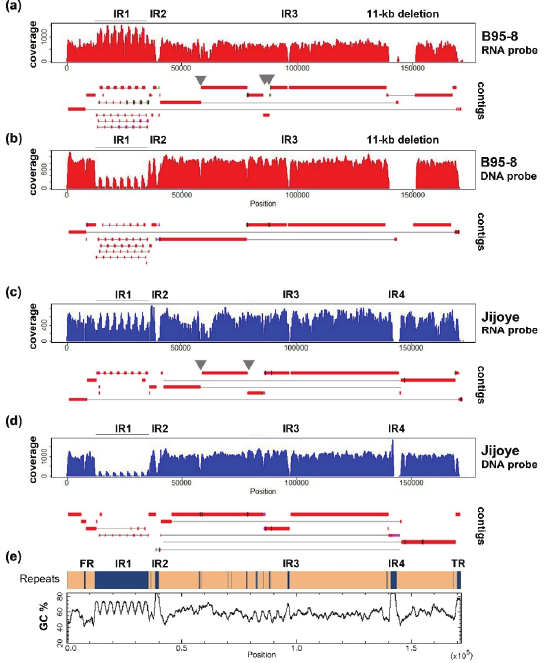
Figure 2. Coverage and alignment of contigs of B95-8 and Jijoye EBV by different capture strategies and sequencing protocols. ( a ) B95-8 EBV captured by RNA bait and sequenced by MiSeq PE150; ( b ) B95-8 EBV captured by DNA probe and sequenced by MiSeq PE300; ( c ) Jijoye EBV captured by RNA-bait and sequenced by MiSeq PE150; ( d ) Jijoye EBV captured by DNA probe and sequenced by MiSeq PE300; and ( e ) distribution of repeat regions and GC percentage across the EBV genome. The GC percentage plot is created by EMBOSS Cpgplot.